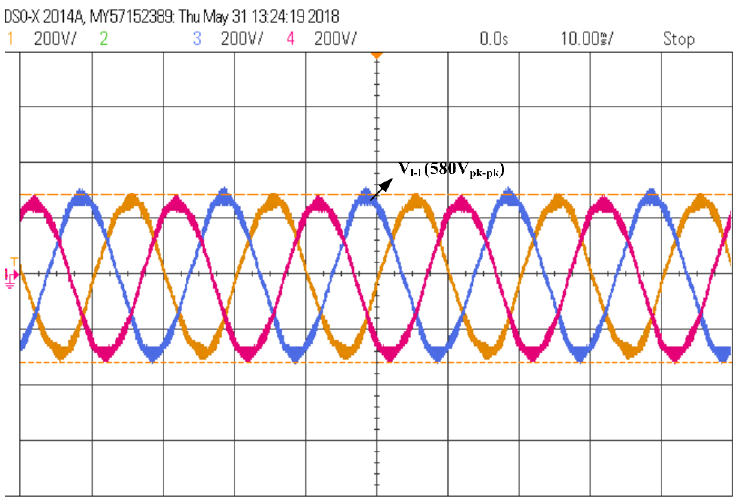
Figure 18. Output line voltage of NPC inverter.